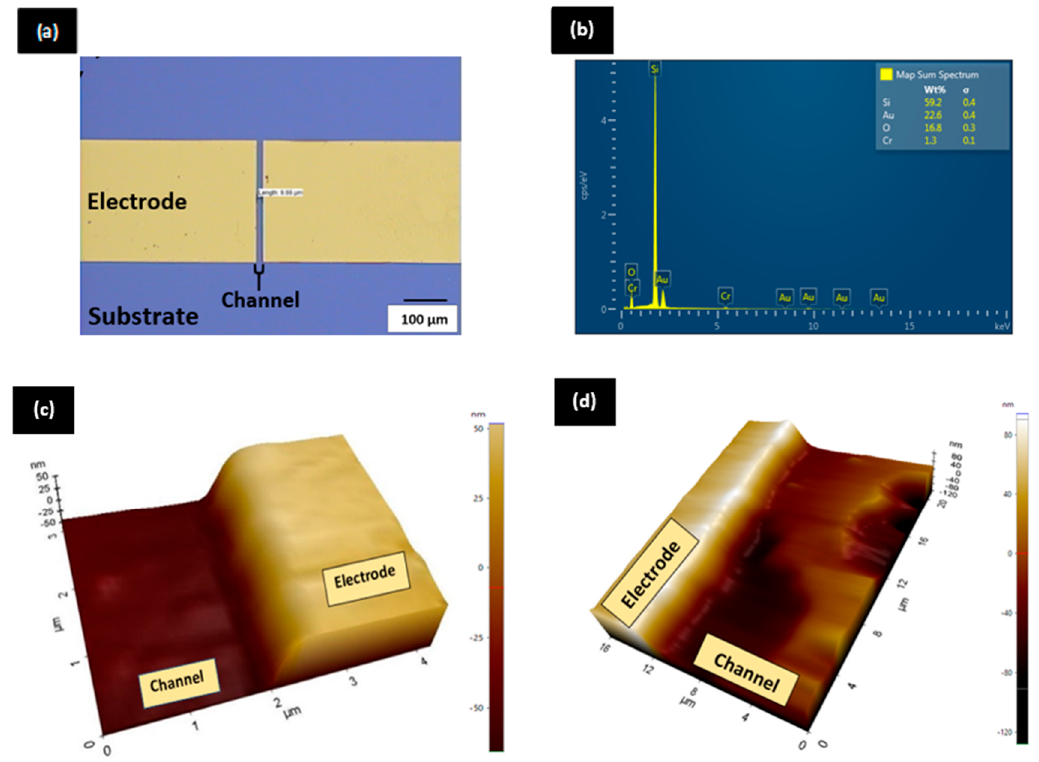
Figure 2. ( a ) Optical microscope image of graphene-based field-effect transistor (GFET) with 10 µm channel length; ( b ) energy-dispersive X-ray analysis (EDX) spectrum for GFET device; ( c ) atomic force microscopy (AFM) image for bare GFET and ( d ) AFM image of GFET after ADH detection.